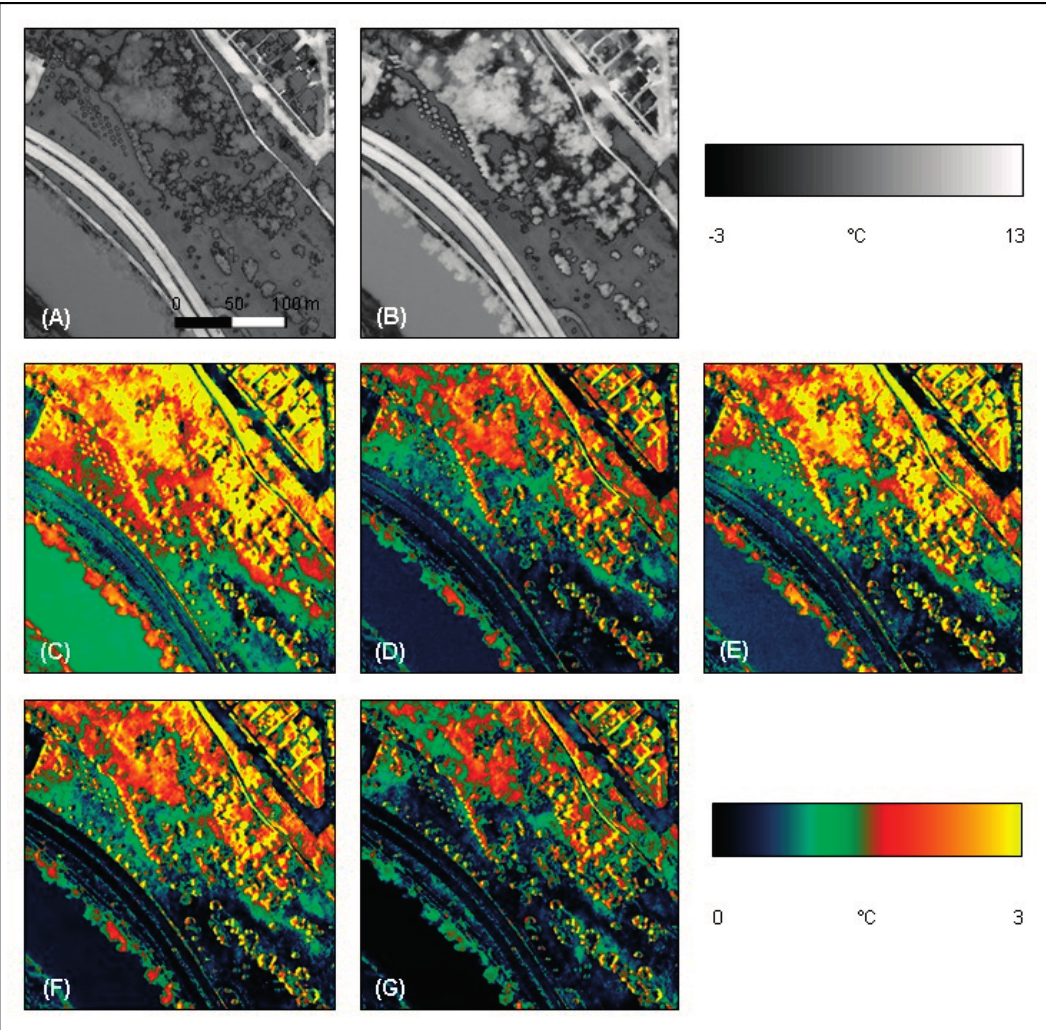
Figure 6. A visual example of how relative radiometric normalization techniques decrease the radiometric variability between flight lines. ( A ) A sample area from the master image. ( B ) The same area from the slave image. Pseudo-colored absolute image difference ( C ) between the master and the uncorrected slave image and between the master and the normalized salve images resulting from ( D ) HM, ( E ) PIF_Poly, ( F ) NCSRS_Lin and ( G )